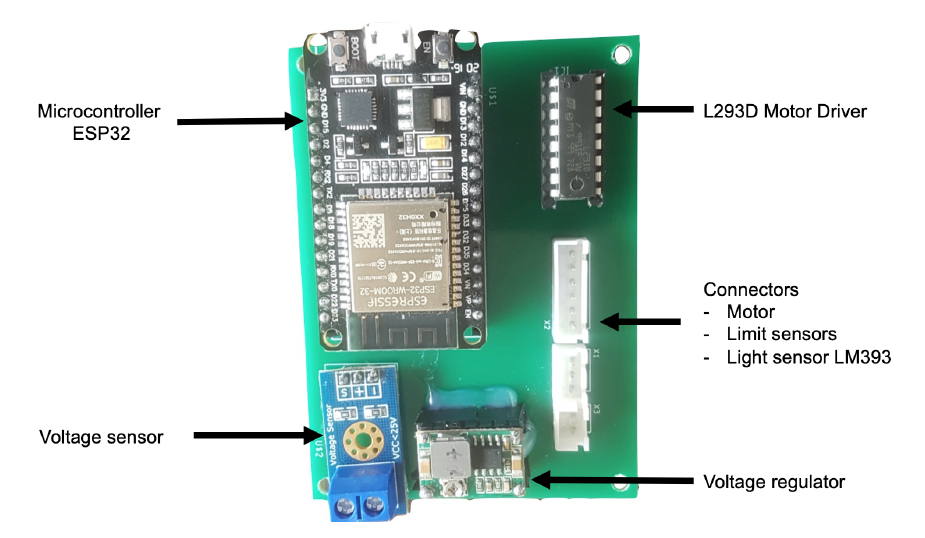
Figure 13. Final version of the electronic board.